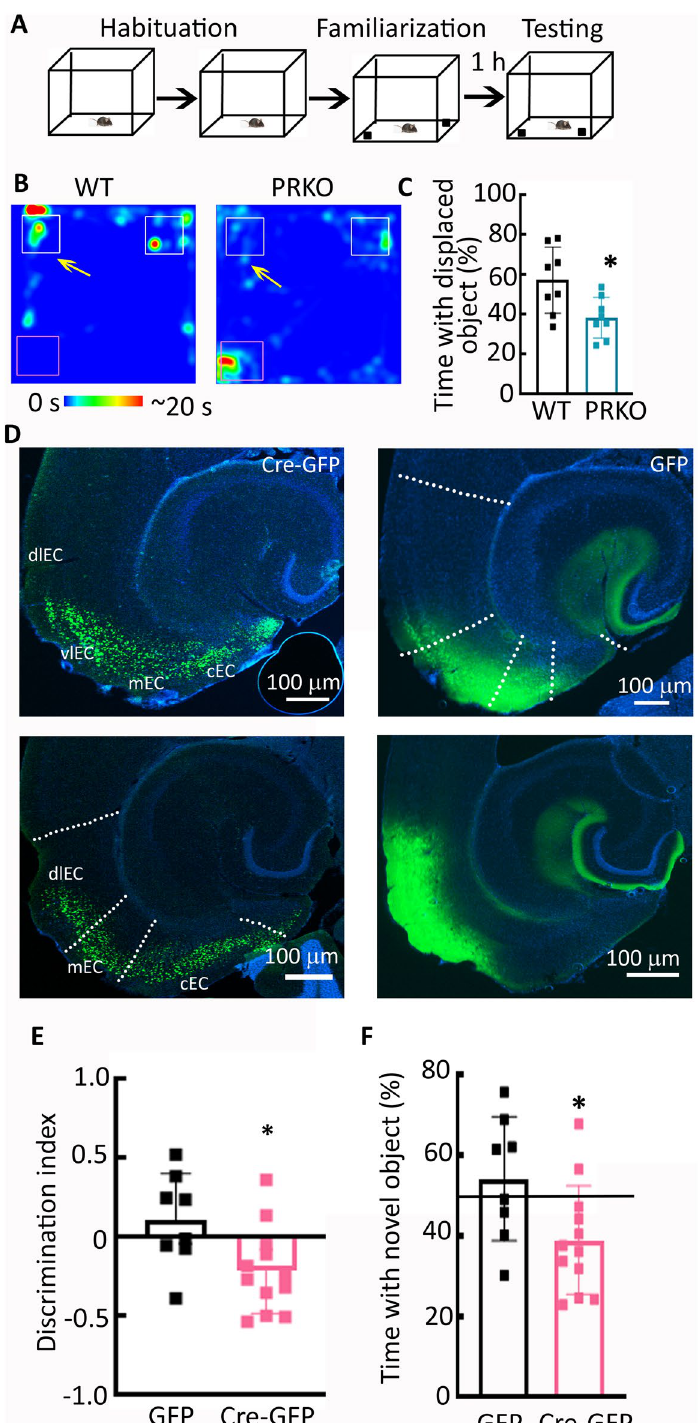
Figure 5. The effect of PR deletion on object place recognition and EC-specific deletion on novel object recognition. ( A ) The schematic showing object place recognition testing. ( B ) Heat map from representative WT and PRKO mice during the testing phase. The arrows mark the displaced object; purple squares mark their original position. The animals were tested after an hour. ( C ) The percent time spent in exploring the displaced object, n = 8 each, * p = 0.016 student’s t-test. ( D ) Images from representative animals injected with AAVs to express CamKII-driven Cre-GFP or GFP alone. Sections from the ventral and dorsal EC cortex are shown, the green fluorescence corresponds to Cre-GFP or GFP expression, and DAPI (blue) was used as a counterstain. ( E ) Discrimination indices in the Cre-GFP and GFP mice, * p = 0.0212, student’s t-test. ( F ) Percent novel object exploration in the animals injected with AAVs to express CamKII driven Cre-GFP or GFP alone, n = 8 for GFP alone and 12 for GFP-Cre, * p = 0.017 one sample t-test for Cre-GFP mice. The black line marks a chance performance